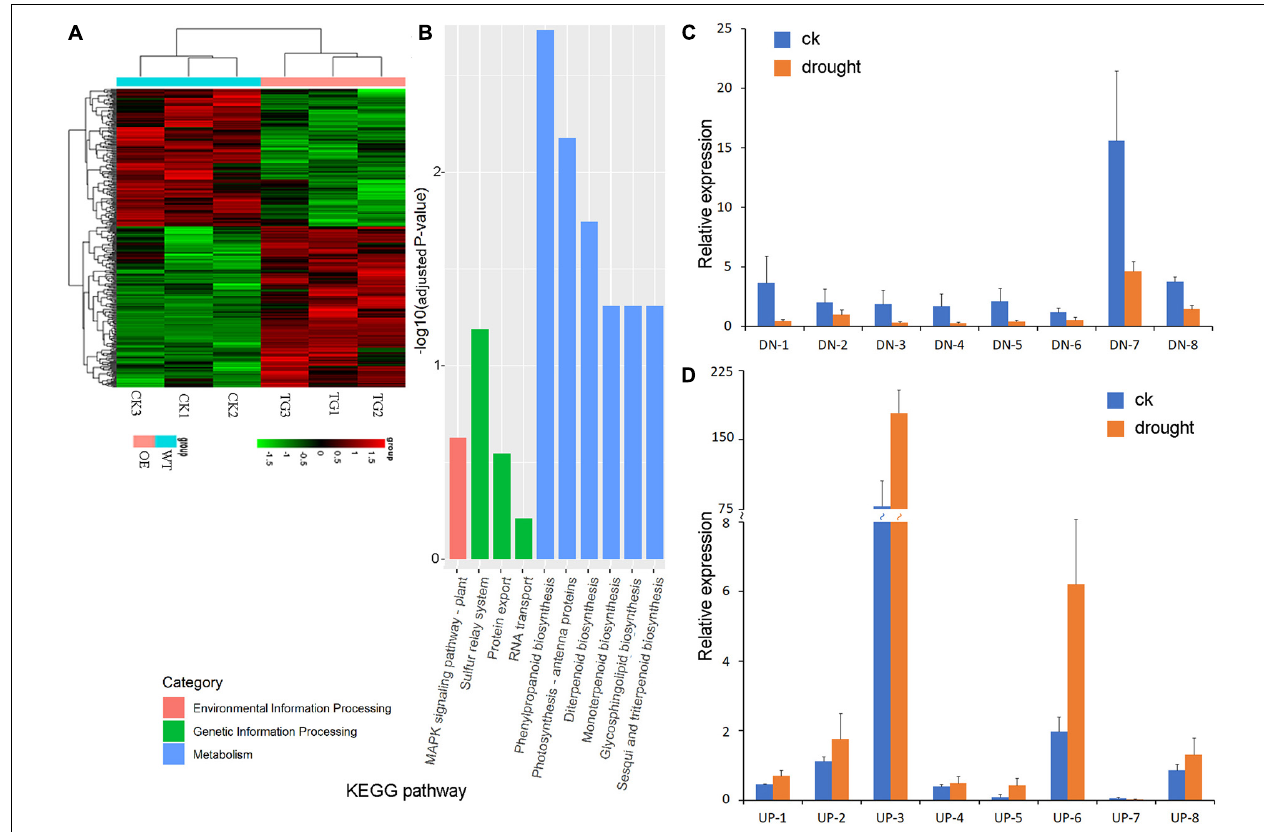
FIGURE 6 | Transcriptome analysis of PpBURP2 transgenic plants. (A) Clustering results of differentially expressed genes in RNA-sequencing experiment. Each row represented a log2-fold change of the relative gene expression. Upregulated expression genes were colored red, downregulated expression genes were colored green, and black represented no significant expression. CK1-3 indicates the three different samples of the WT, and TG1-3 indicates the three different samples of the PpBURP-OE1 transgenic plant. (B) Histogram of the Kyoto Encyclopedia of Genes and Genomes (KEGG) pathway enrichment results. The X -axis is the name of the pathway, and the Y -axis is -log10 (adjusted p -value) enriched by each pathway. (C) Relative expression level of downregulated genes in transgenic plants and WT. (D) Relative expression level of upregulated genes in transgenic plants and WT. The data represent the means ± SE ( n =